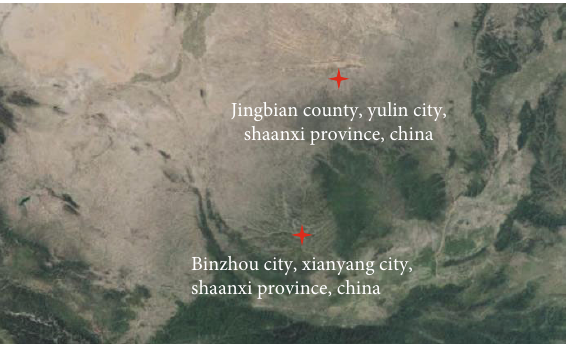
Figure 2: Sampling site location. Table 1: Physical properties of soil